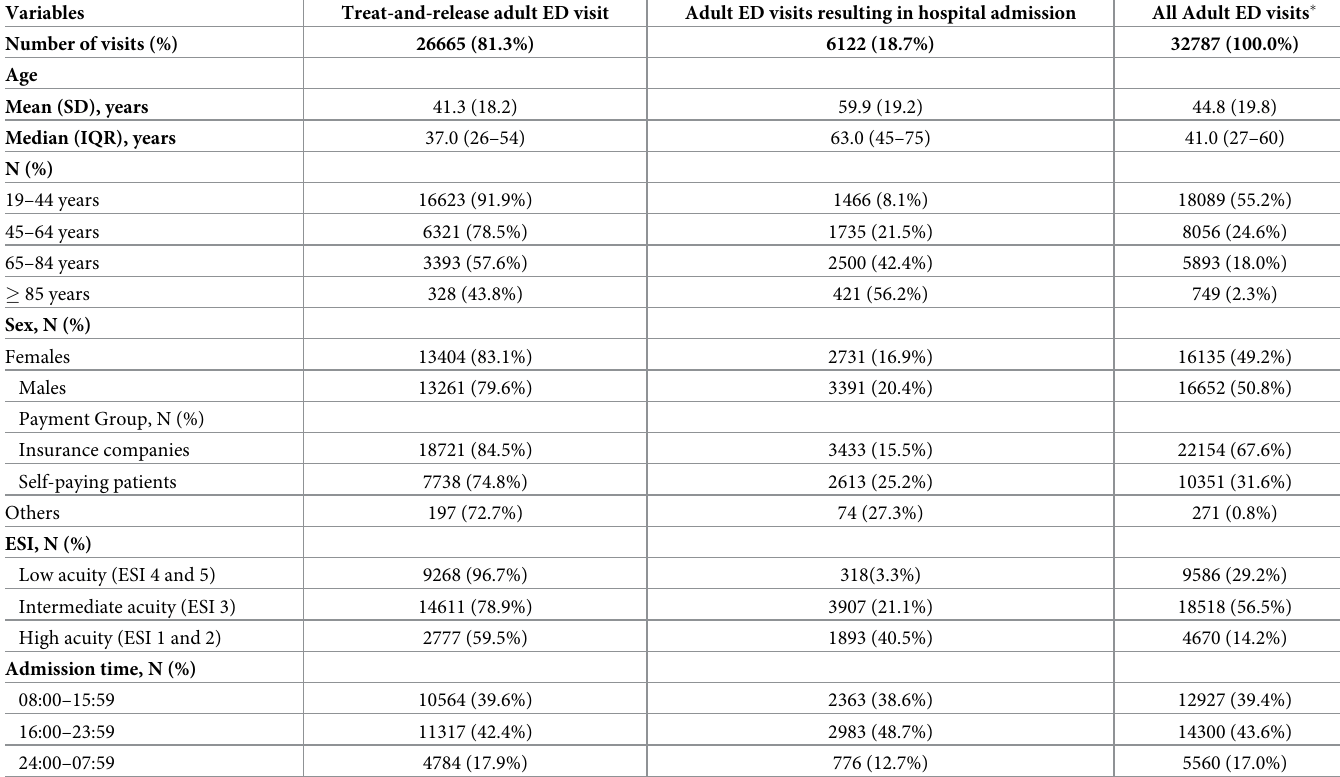
Table 1. Demographic characteristics of adult ED visits